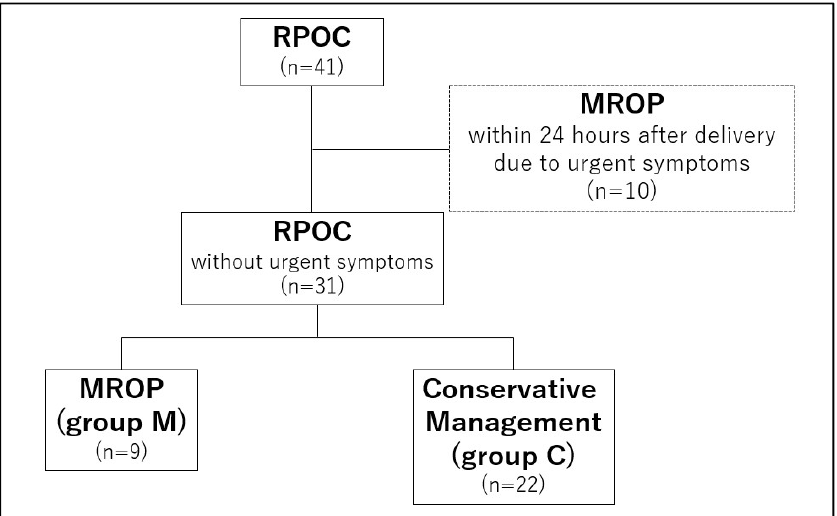
Figure 1. Flowchart of the present study. RPOC: retained products of conception. MROP: manual removal of placenta.